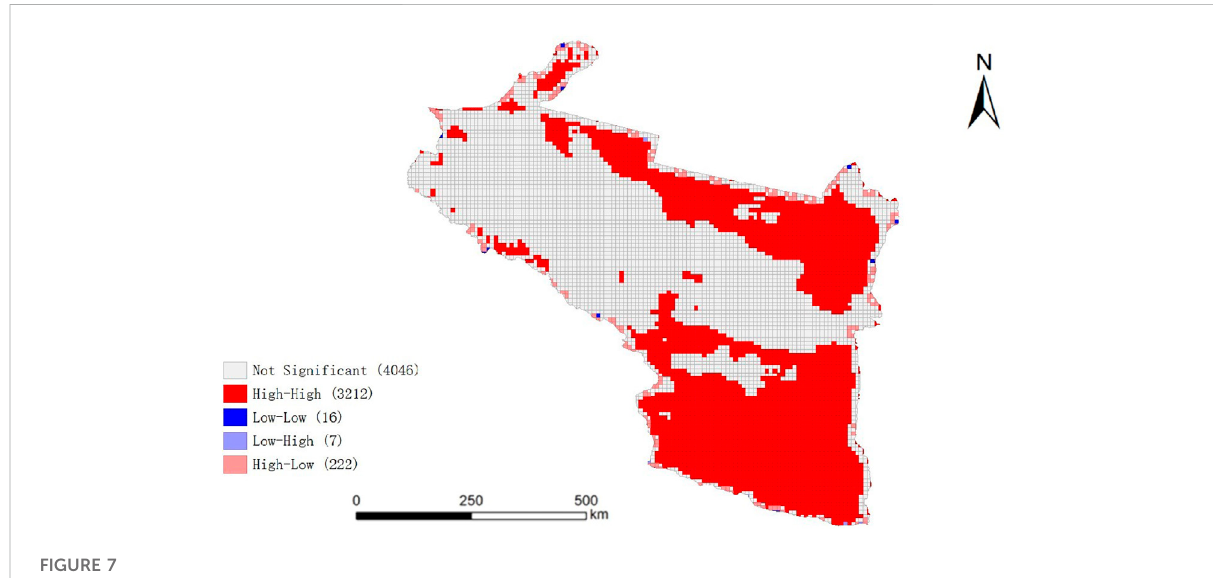
FIGURE 7 Spatial autocorrelation